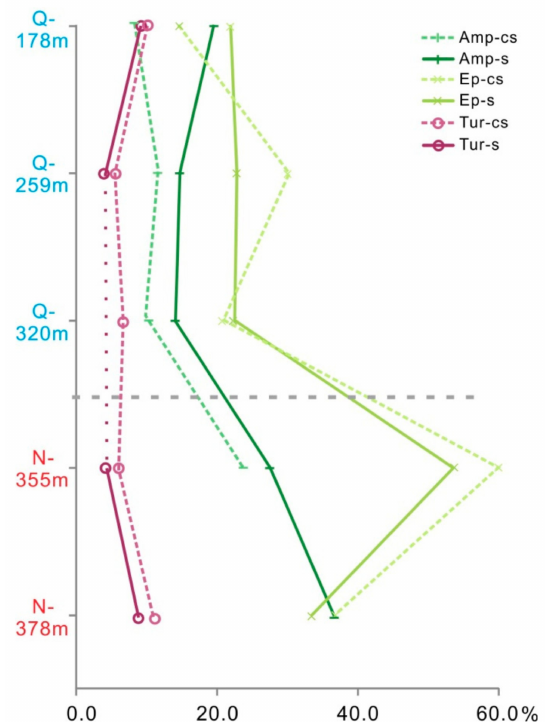
Figure 8. Percentage of corroded single mineral grains in the Core LQ24 of Changjiang Delta. A very fine sand fraction (63–125 µ m) is indicated by full lines and coarse silt (32–63 µ m) is indicated by dashed lines. N = Pliocene, Q =